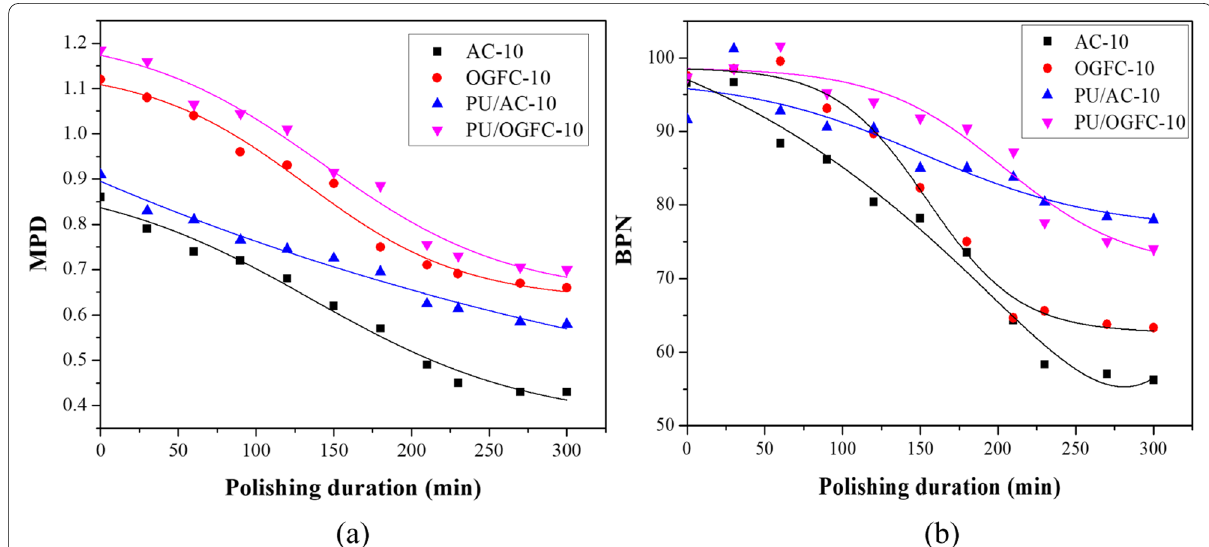
Fig. 5 The comparison of skid resistance between the polyurethane mixture and asphalt mixture [39]: a The mean profile depth (MPD) test values; b The British pendulum number (BPN) test values